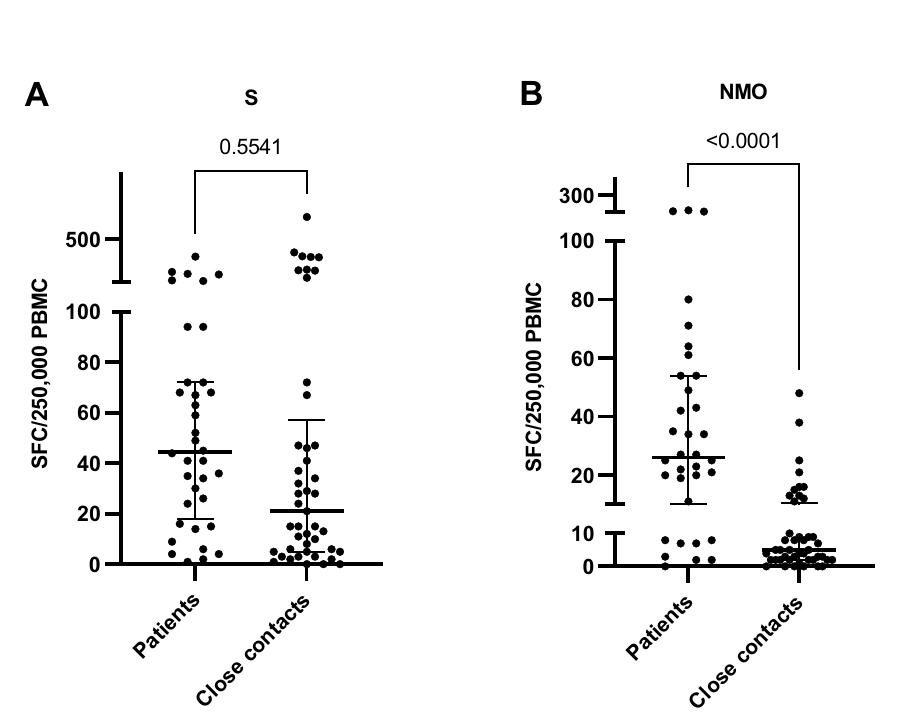
Table 1. Demographic data.